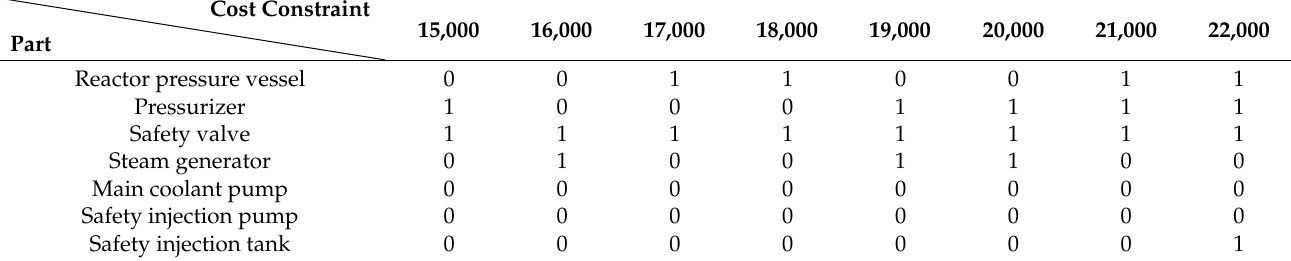
Table 4. X10 failure, t = 600 h.